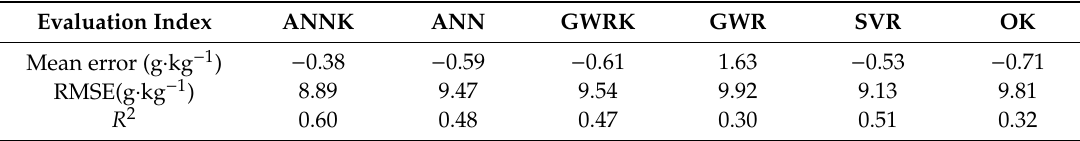
Table 5. Performance evaluation of six